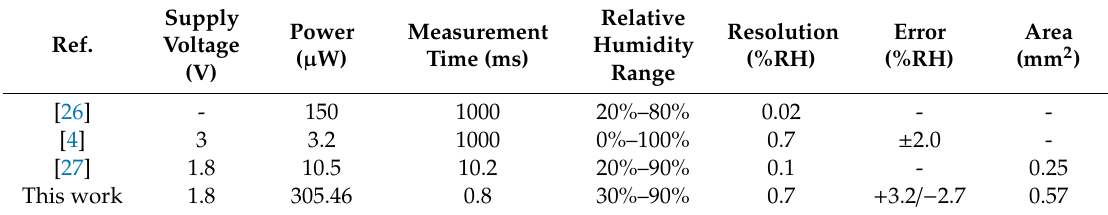
Table 2. Performance comparison with previously reported humidity